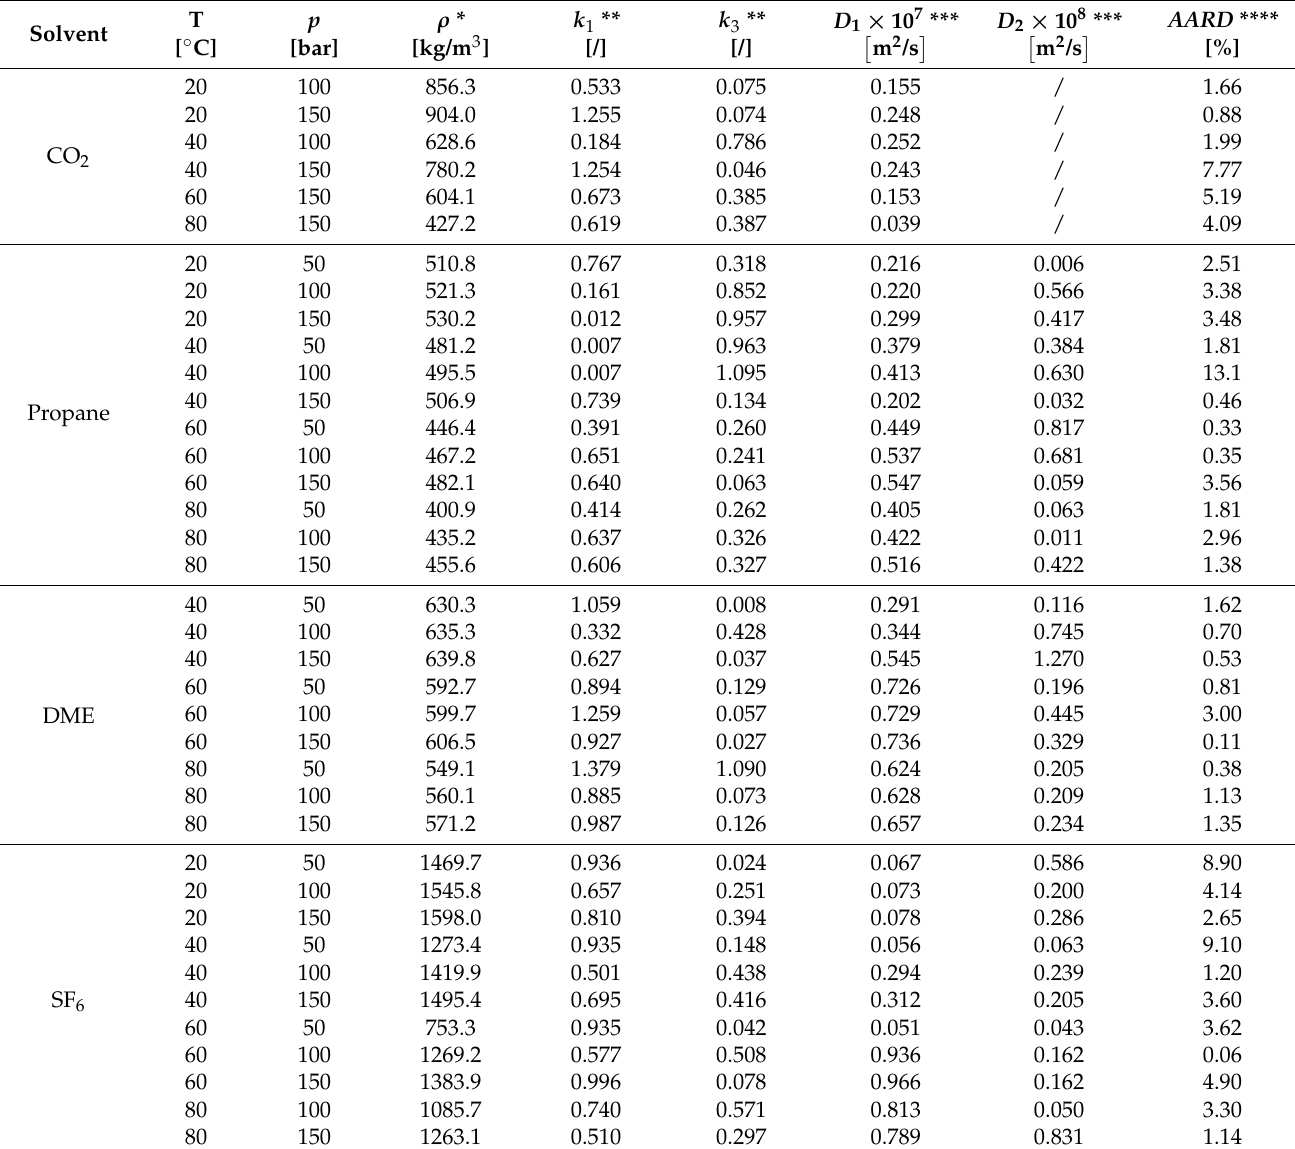
Table 1. Model adjustable parameters for extraction of hops with respect to experimental conditions.